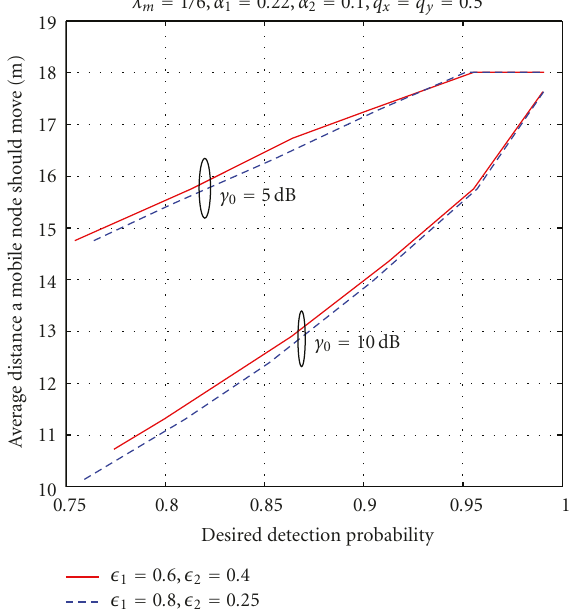
Figure 9: Dependence of the average distance that a mobile node should move in order to achieve a desired detection probability, on initial detection performance (cid:2) 1 and (cid:2) 2 ; T s = 1s, v = 1 m/s, p k